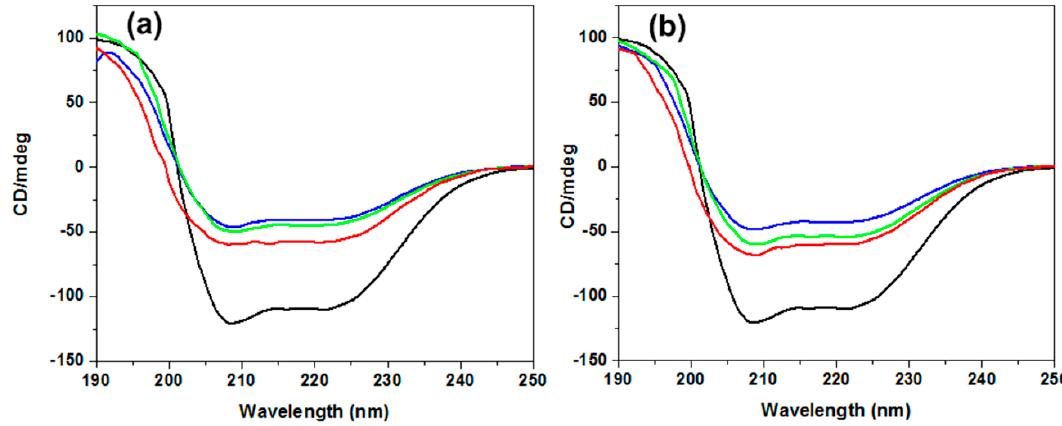
Figure 2. Far-UV CD spectra of BSA (black line) and BSA in the presence of PGA-1 ( a ); and PGA-1.5 ( b ). The concentrations of polymers are 0.05% (red line), 0.1% (green line), and 0.5% (blue